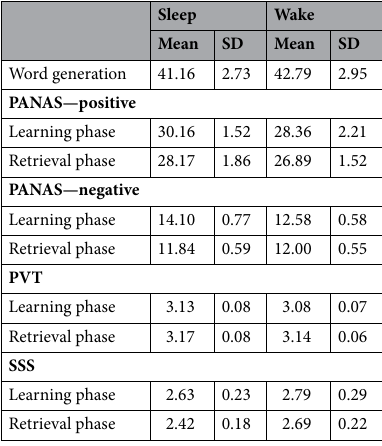
Table 1. Data for control